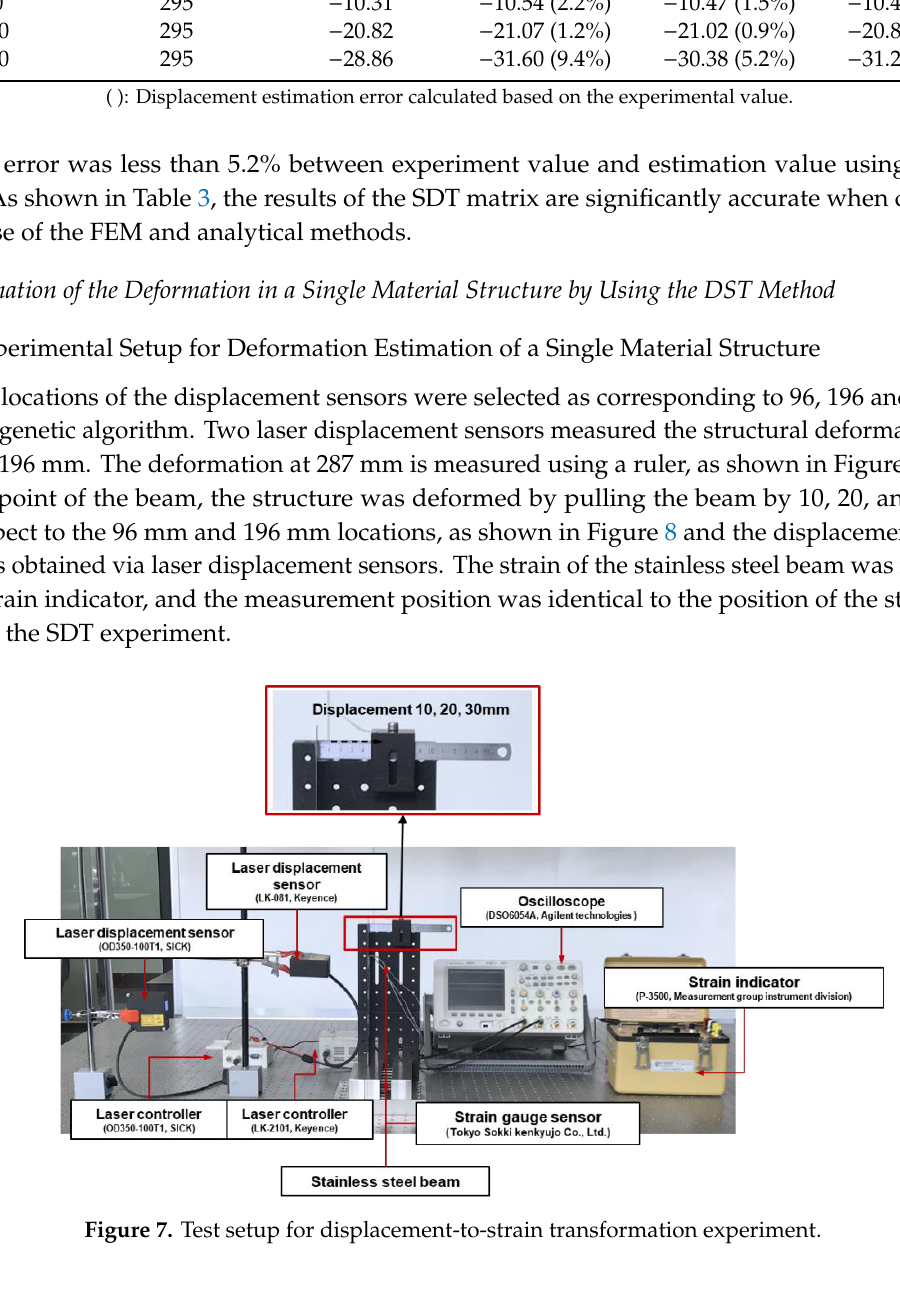
Figure 8. Measurement points of the multilayer beam.